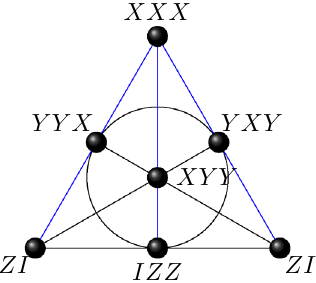
Figure 5. An example of the (negative) Fano plane in W ( 5, 2 ) ; the blue lines are negative